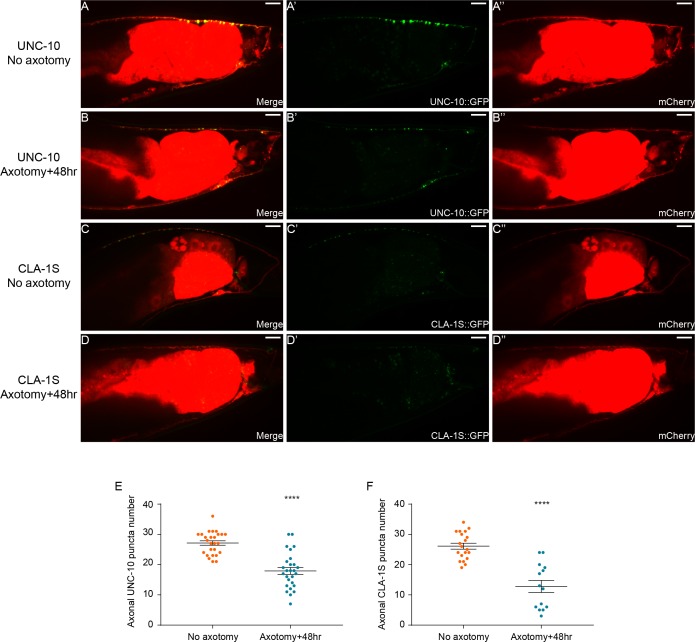
Regeneration of other presynaptic components.(A–A’’) UNC-10 localization in intact DA9. Scale bars = 10 μm. (B–B’’) UNC-10 localization in regenerated DA9. Scale bars = 10 μm. (C–C’’) CLA-1S localization in intact DA9. Scale bars = 10 μm. (D–D’’) CLA-1S localization in regeneration DA9. Scale bars = 10 μm. (E) Quantification of axonal UNC-10 puncta number. ****, p<0.0001. Unpaired t test. (F) Quantification of axonal CLA-1S puncta number. ****, p<0.0001. Unpaired t test.